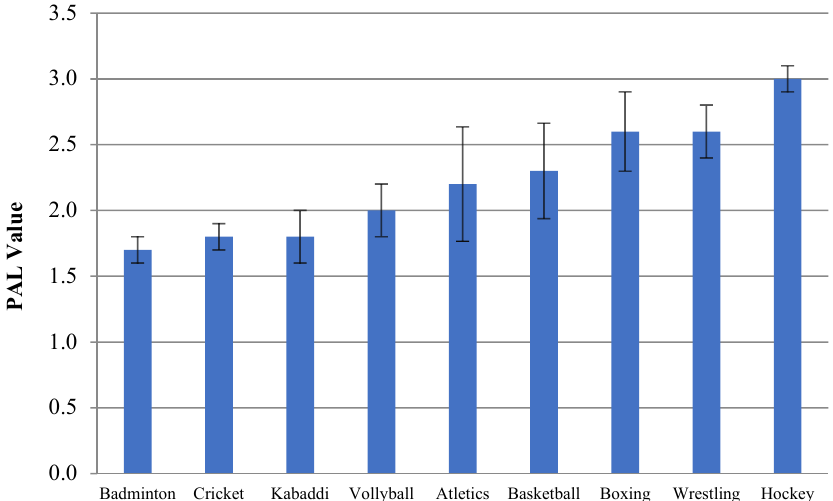
Figure 4. PAL values in athletes of different sports.